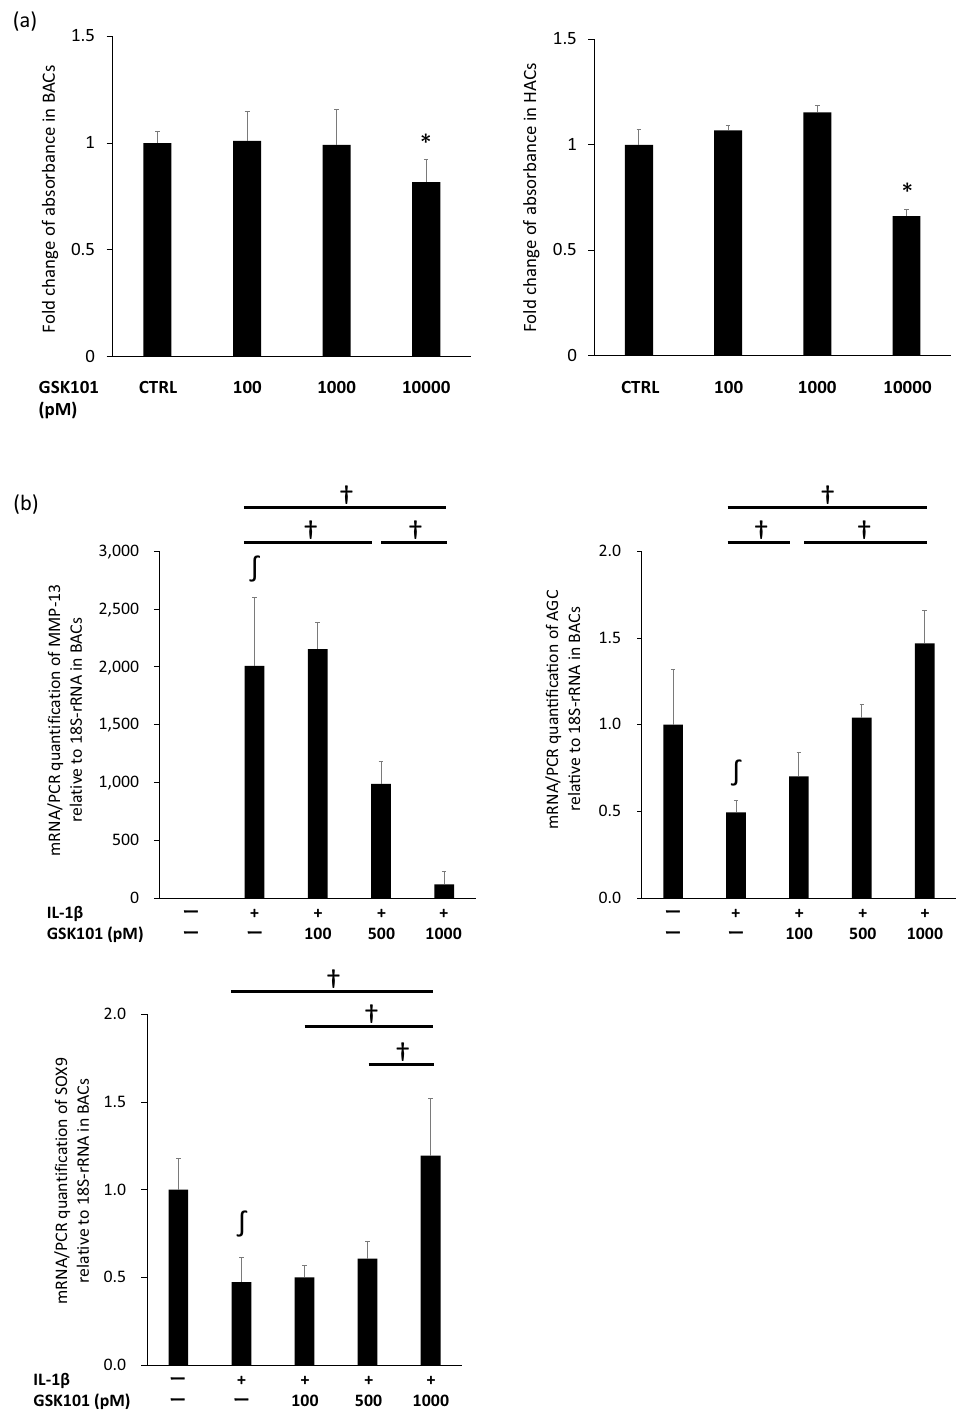
Figure 1. Optimization of GSK101 concentration. The optimal concentration of GSK101 for experiments was determined to be 1000 pM based on 48-h MTS assays in BACs and HACs, and real-time PCR-determined expression levels of MMP-13, aggrecan and SOX9 12 h after treatment in BACs. Experiments were repeated three times. ( a ) In the MTS assay, GSK101 was not cytotoxic both to BACs and HACs at concentrations of up to 1000 pM, but was cytotoxic at 10,000 pM. ( b ) In the real-time PCR in BACs, GSK101 significantly reversed the IL-1β-induced increase in expression of MMP-13 mRNA and decrease in expression of AGC and SOX9 mRNA in a dose-dependent manner. * p < 0.05 compared to untreated control, ∫ p < 0.05 compared to untreated control, † p < 0.05 using one-way ANOVA with Tukey’s test. BAC: bovine articular cell; CTRL: control; HAC: human articular